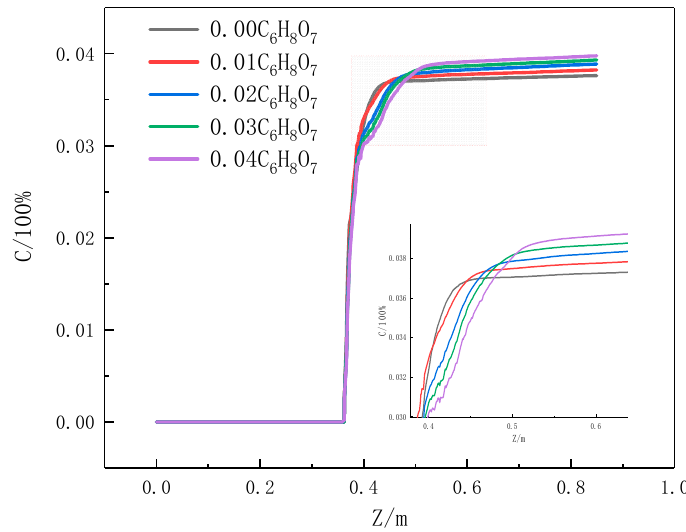
Figure 12. Relationship between the highest CeO 2 concentration and various citric acid ratios.